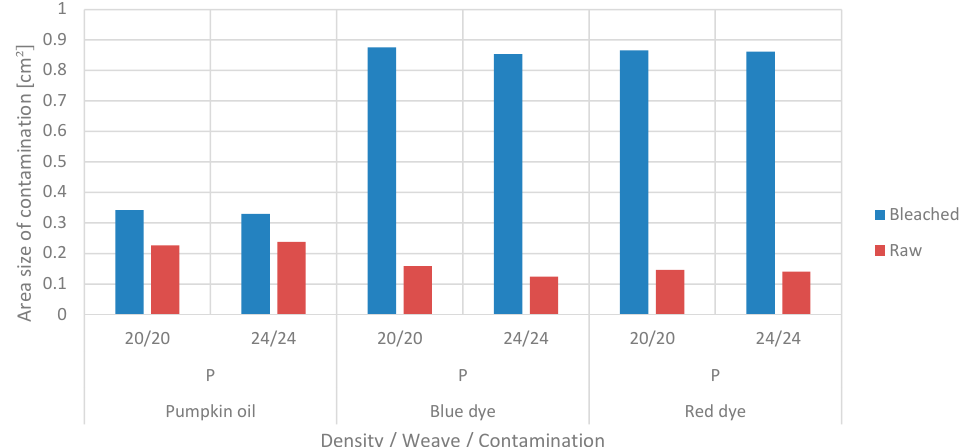
Figure 6. The area of drops (in cm 2 ) on bleached and raw samples in plain weave, with densities of 20/20 threads/cm and 24/24 threads/cm.